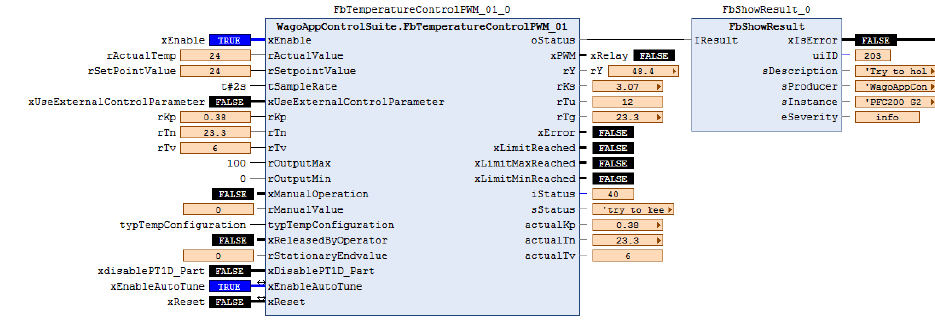
Figure 13. PID function block specialised for temperature